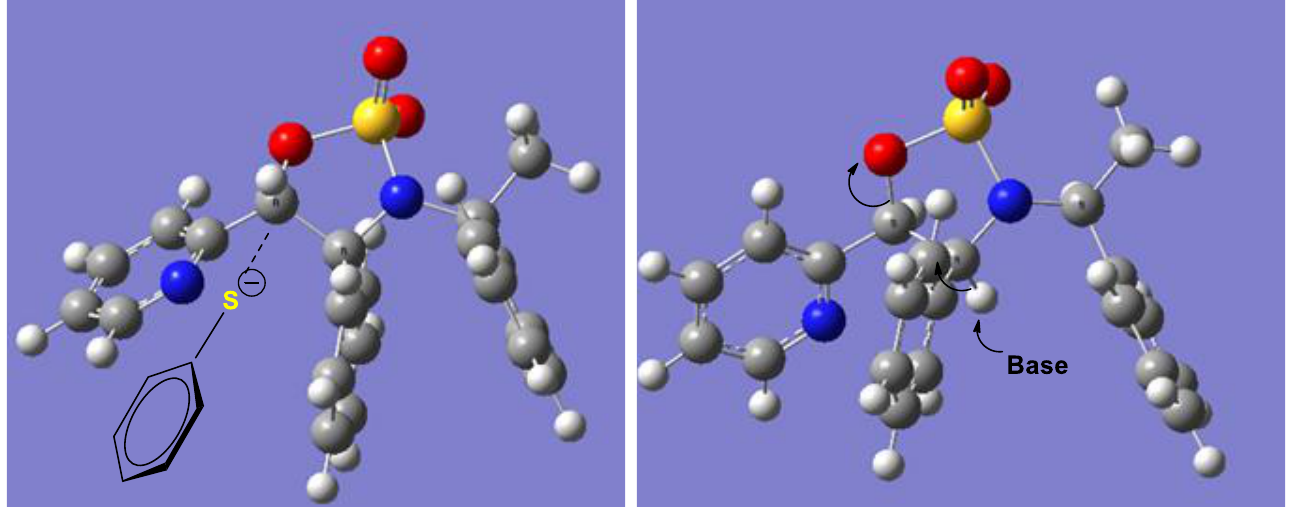
Table 1. Ring-opening reactions of cyclic sulfonamidates.